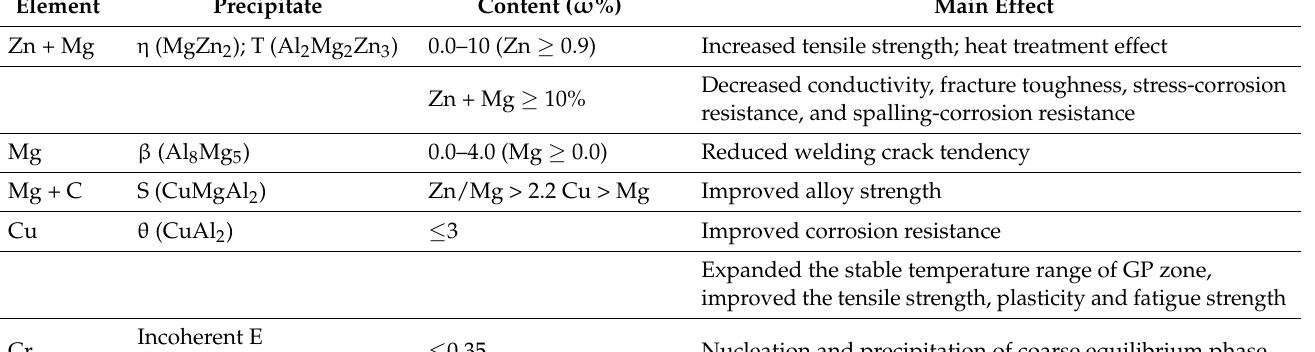
Table 1. Summary of alloy elements on relevant properties of Al-Zn-Mg-Cu